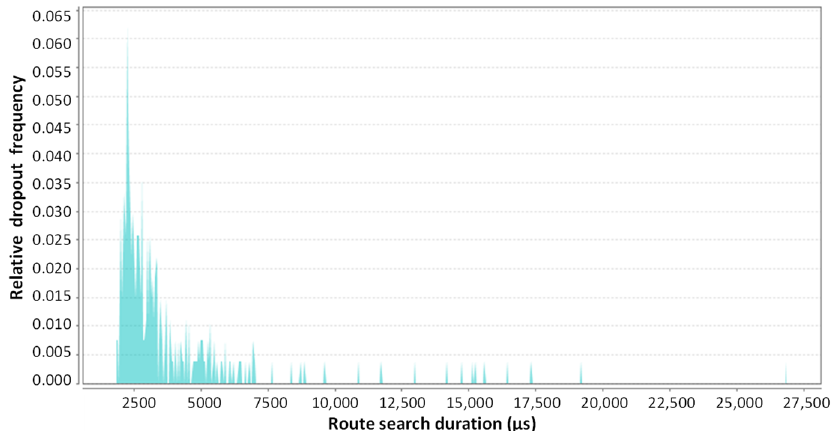
Figure 15. Estimation of the route search duration in the functioning of 18 nodes in the implementation of an improved clustering algorithm.